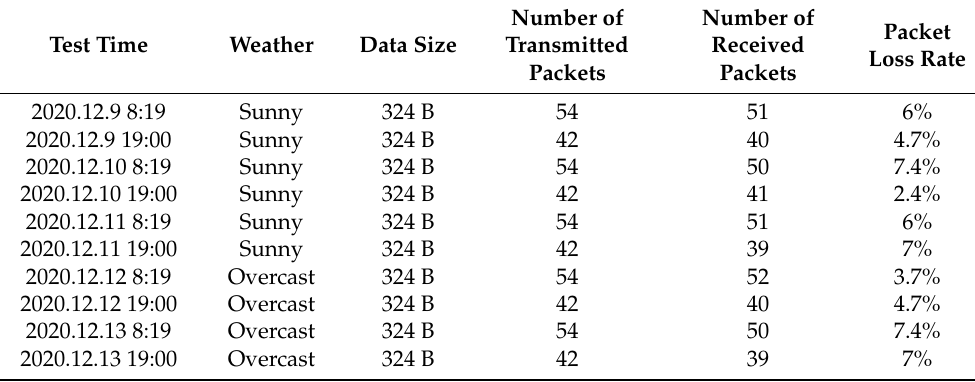
Table 5. Packet loss rate (with the packet creation